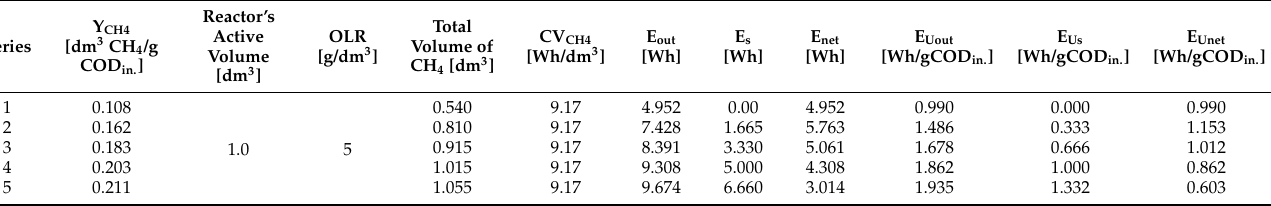
Table 8. Energetic efficiency in particular experimental series.